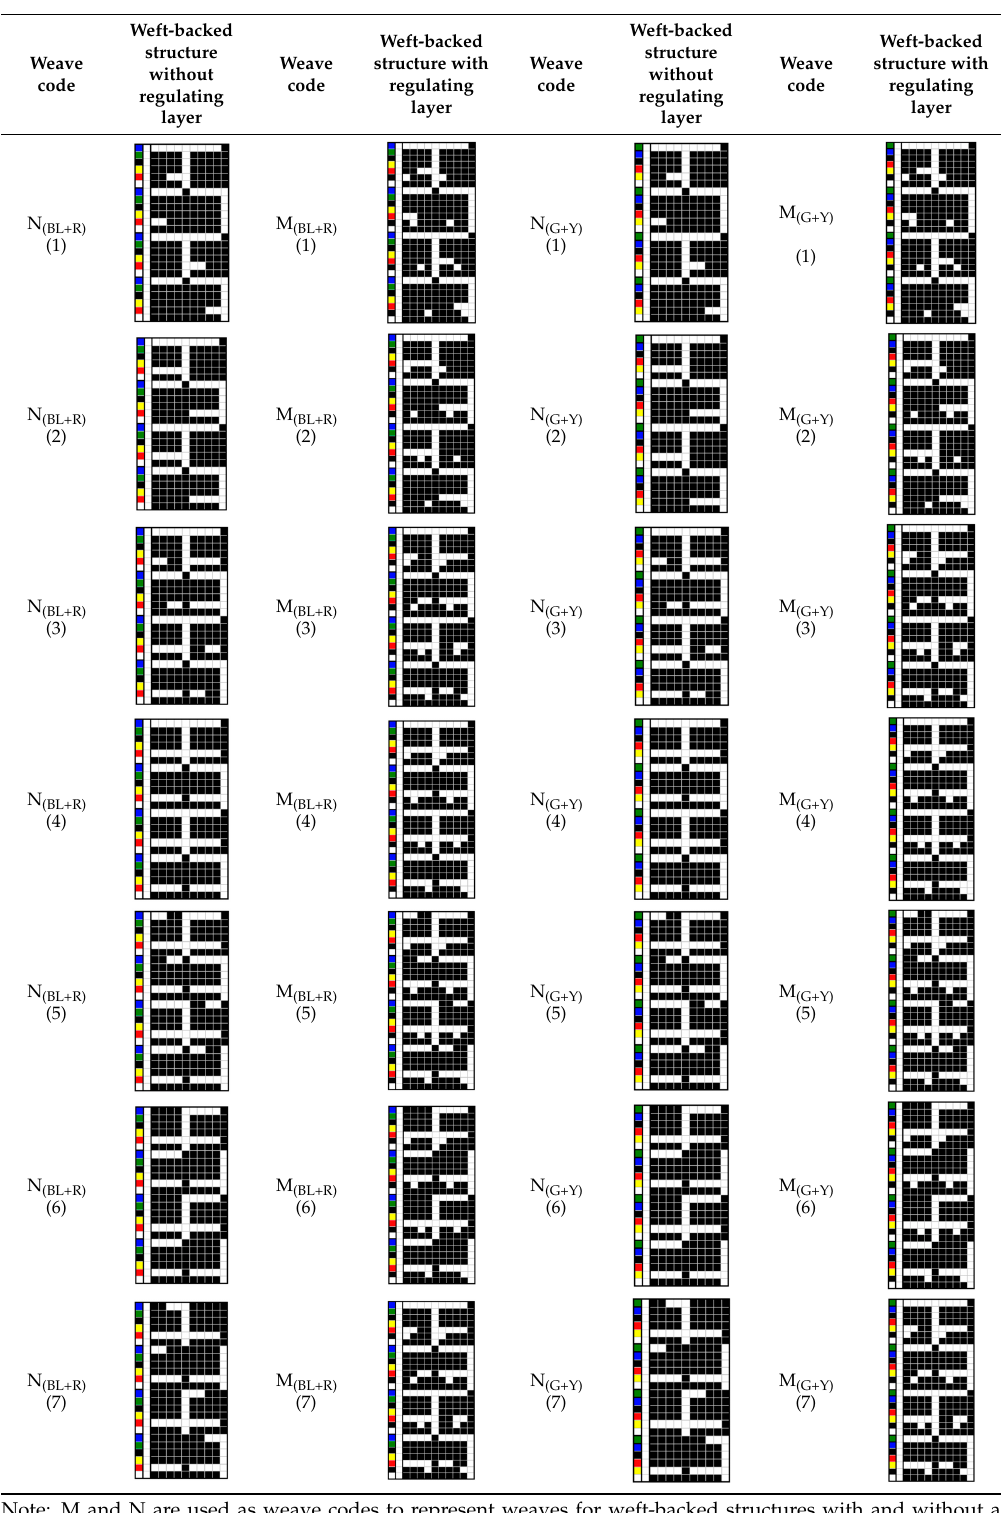
Table 1. Weaves for weft-backed structures, with and without a regulating layer, for weft yarn mixing in blue (BL) and red (R) colors, and in green (G) and yellow (Y) colors, and their varied proportions on the fabric face.